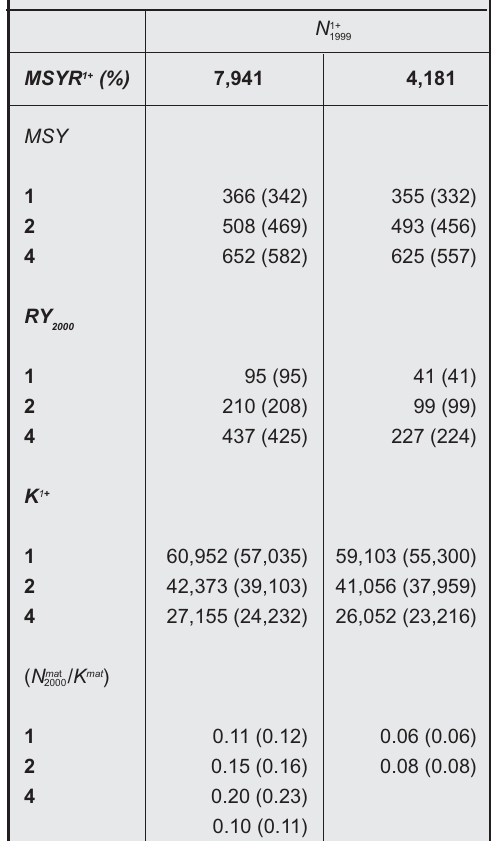
Table 1a. Parameters of population trajectori- es which hit the best estimate (7,941) and cor- responding lower 5%-ile (4,181) total (1+) po- pulation sizes in 1999 for various values of MSYR 1+ for the single stock scenario (“Total” catches) for beluga whales off West Greenland. Results are shown for MSY, RY the pristine (pre-exploitation) total population size ( K 1+ ), and the current status of the mature component of the population relative to pristi- ne ( N ma t / K mat ). Bracketed figures reflect the consequences of excluding estimates from the catch series of the number of whales taken in ice entrapments.